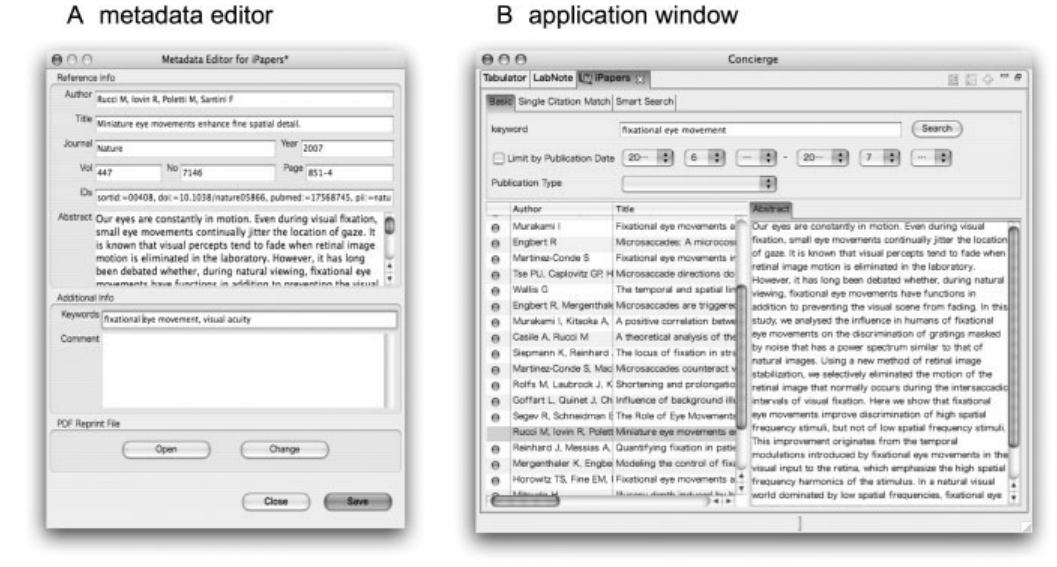
Figure 5. Screenshots of the iPapers plug-in . In the application window ( B ), users can search published articles from the PubMed database and, if necessary, download a PDF reprint and import it to Concierge using bibliographic information ( A ).